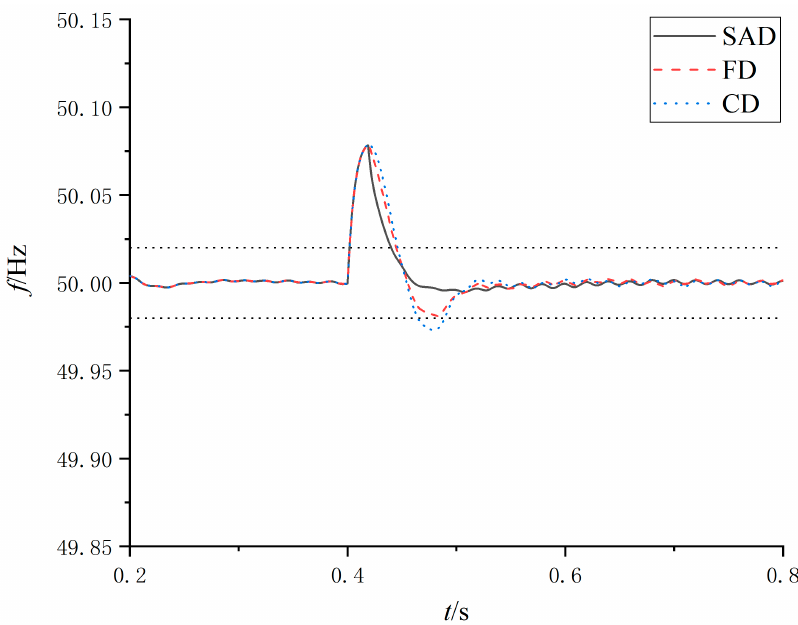
Figure 9. Comparison of frequency under di ff erent damping control strategies in grid-connected mode.